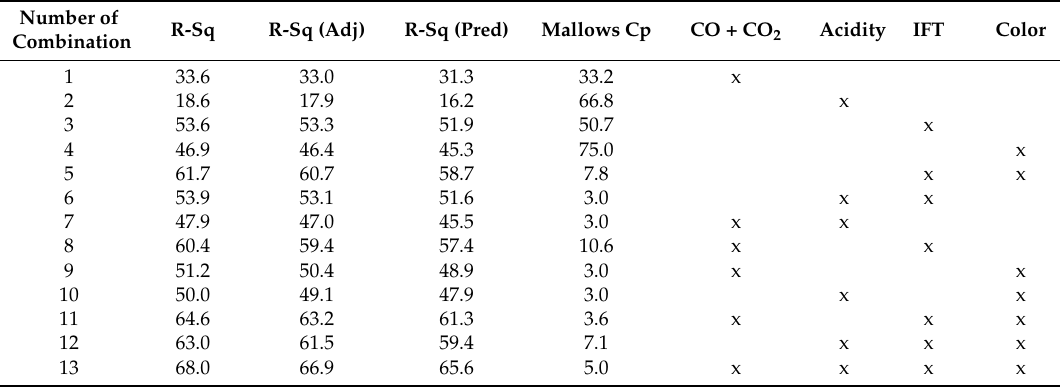
Table 7. Various combinations of independent variables for DP